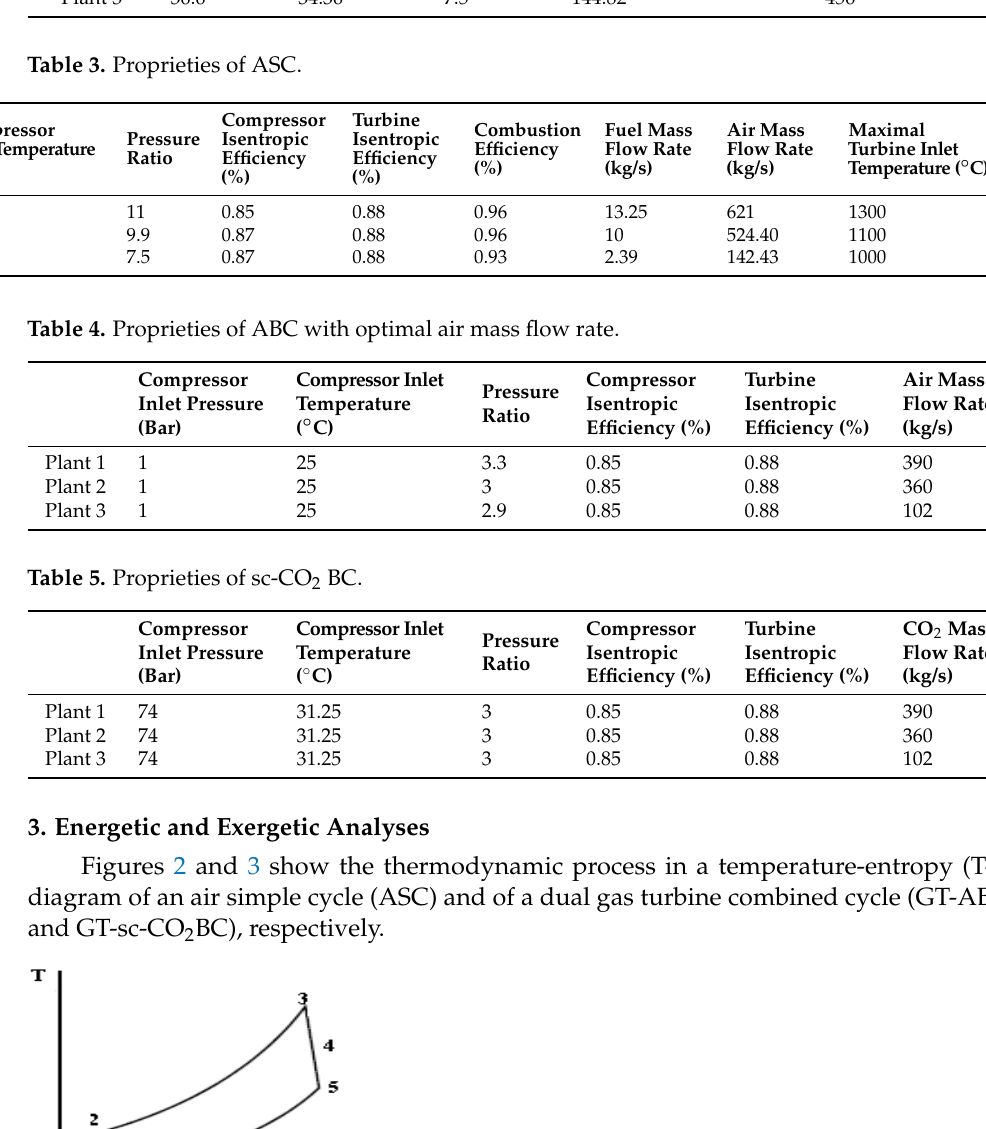
Figure 3. (T-s) diagram of the dual gas turbine combined cycle (1, 2, 3, 4, 5, 7, 8, 9 and 10 are the inlet and outlet of each component of GT-ABC and GT-sc-CO 2 BC in Figure 1b,c). Table 6. Model of energy analysis. Cycle